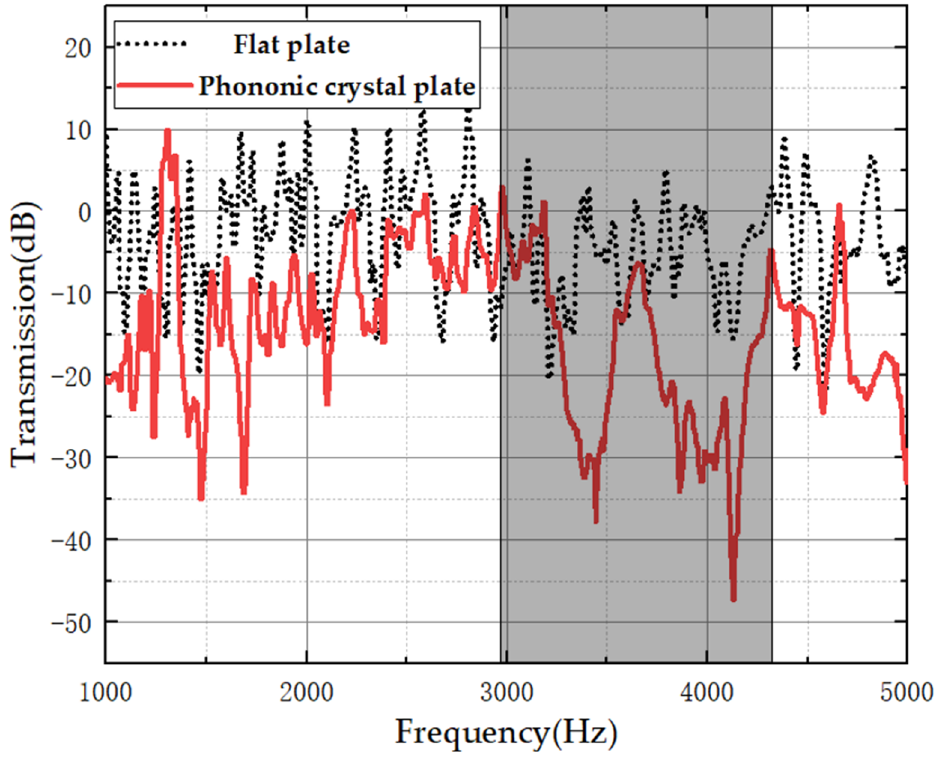
Figure 12. Experimental results.